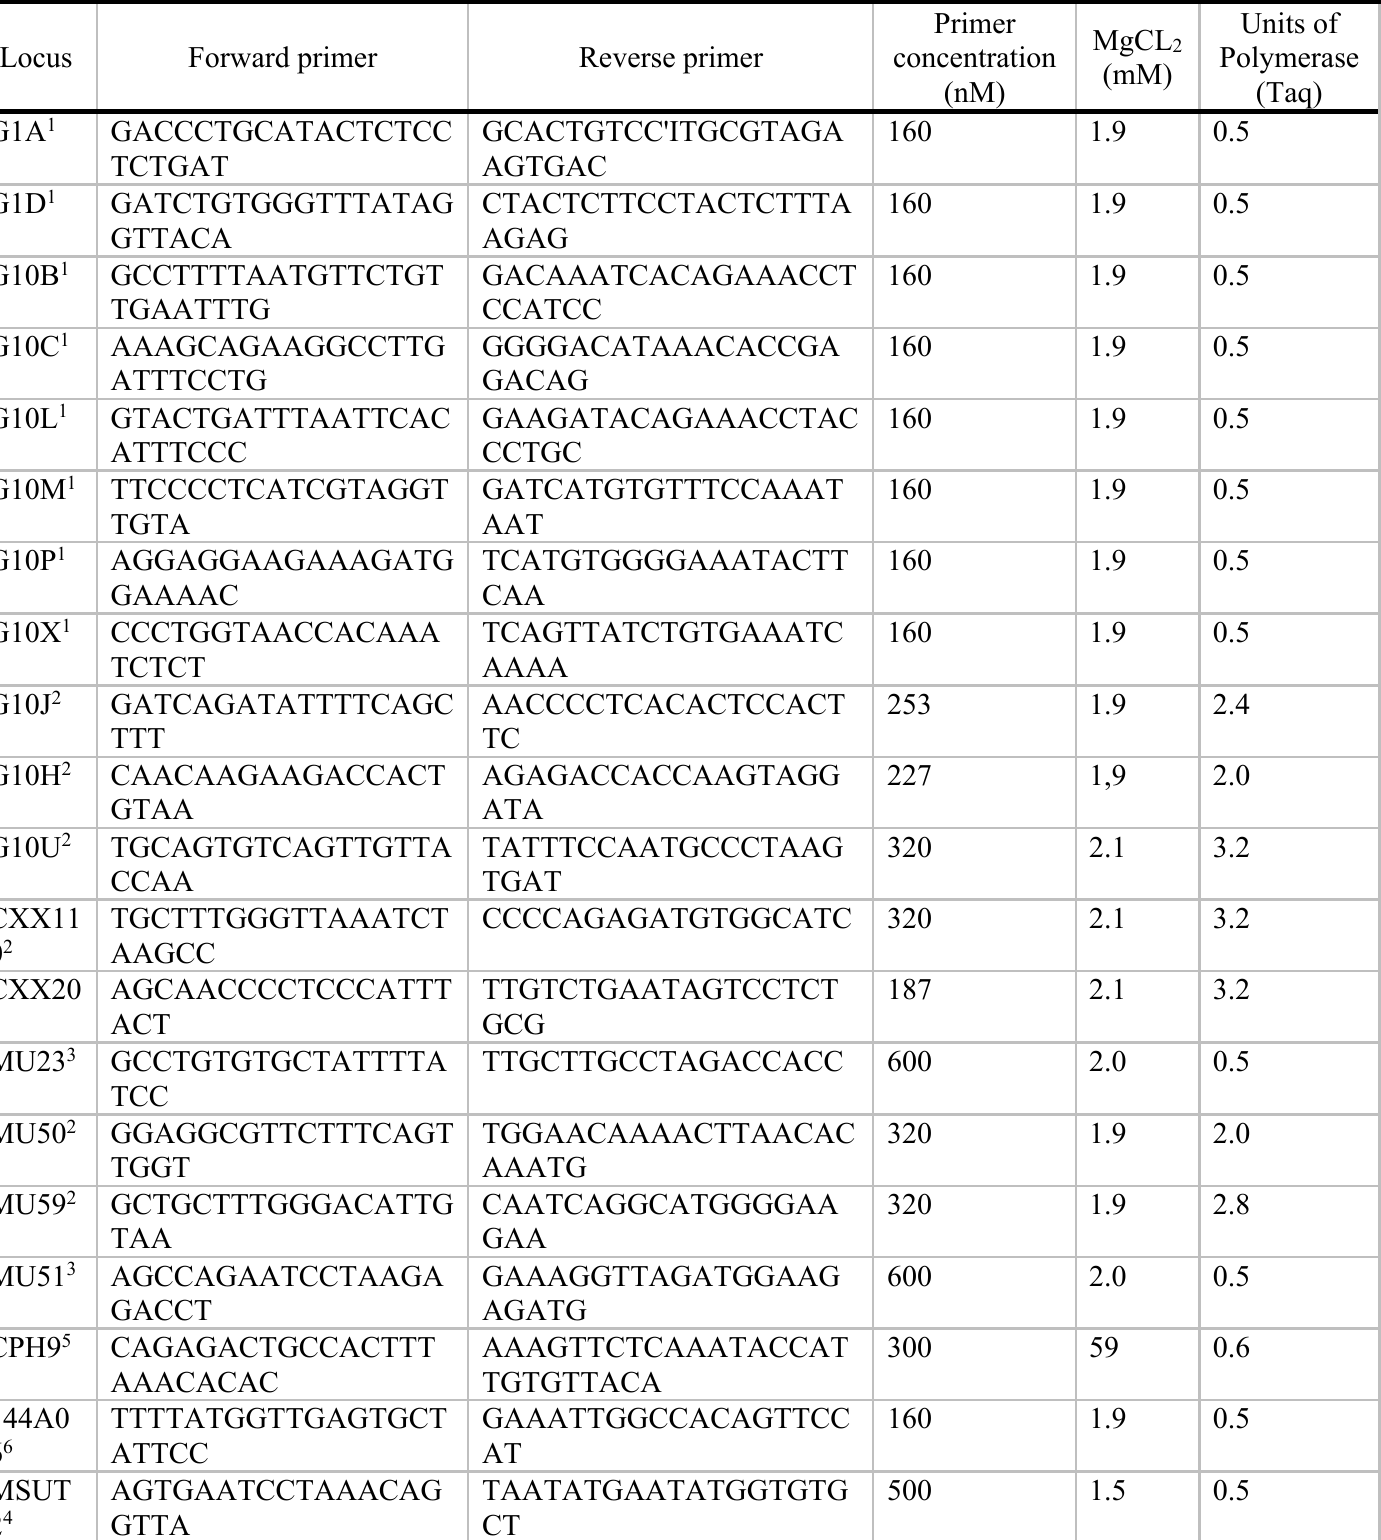
Table A1.1 Microsatellite loci, primer pairs, and PCR reagent concentrations